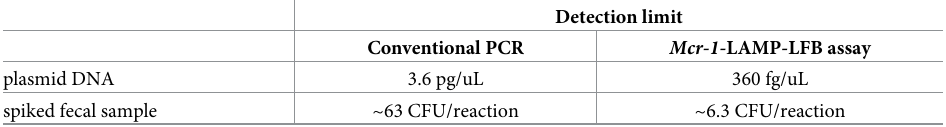
Table 3. Conventional PCR and mcr-1 -LAMP-LFB assay detection